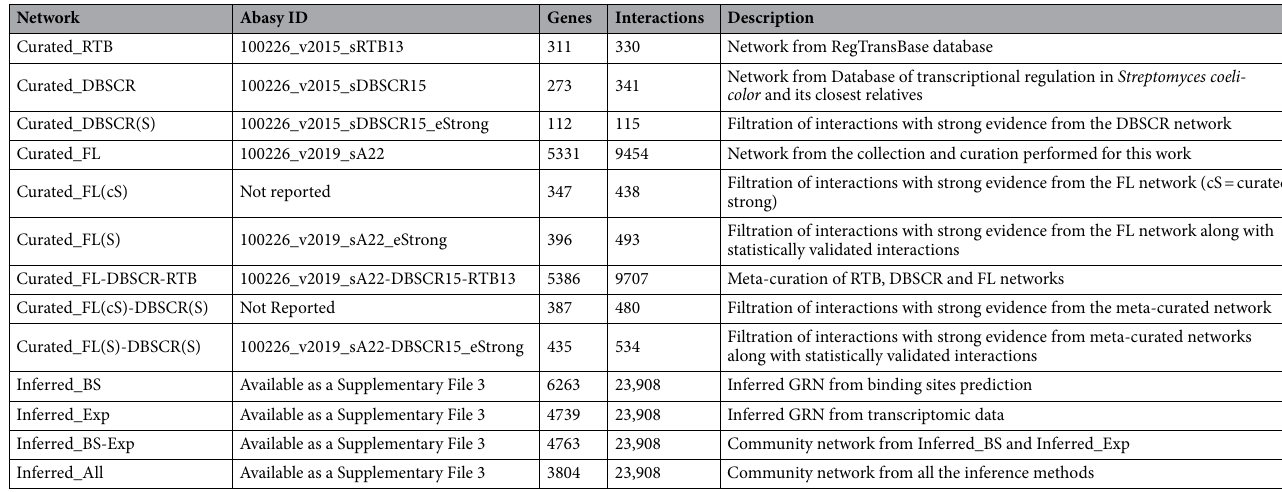
Table 1. Description of networks used in this